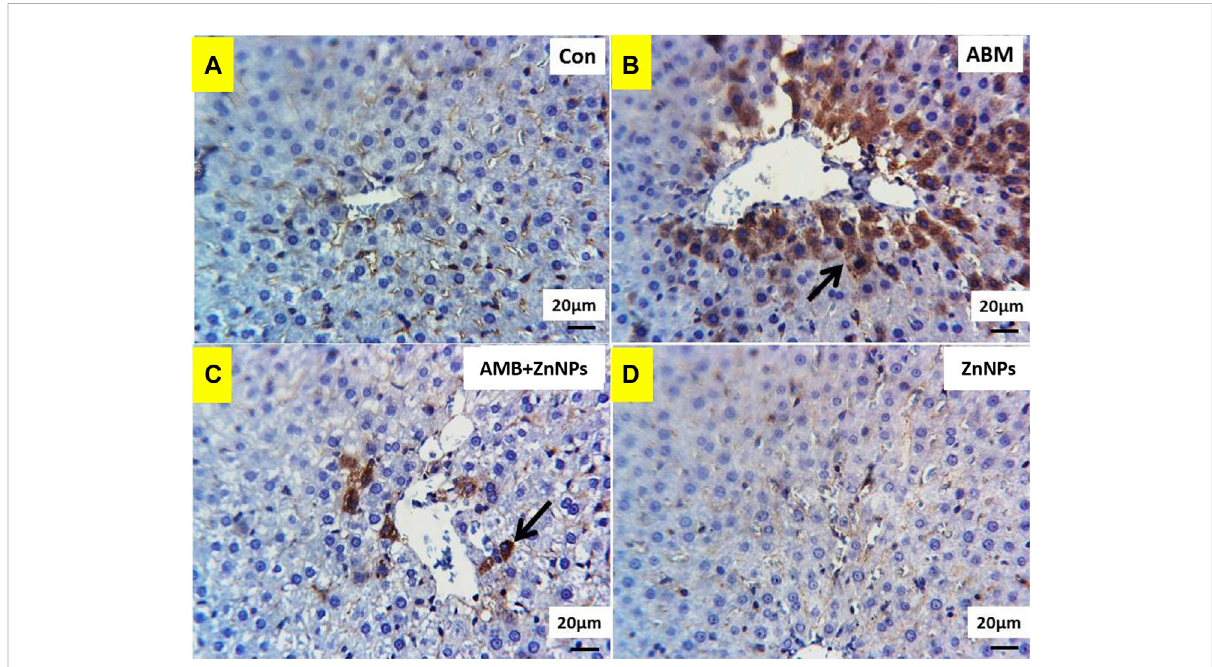
FIGURE 6 PhotomicrographsofCox2immunohistochemistrystaininginhepaticsectionsshowing: (A,D) negativeexpressionsofCox2incontrol(GI)and ZnNPs (G IV), respectively. (B) Massive immunoexpression of Cox2 (arrow) in abamectin (ABM; G II) treated rats group. (C) Reduced immunostaning of Cox2 (arrow) in ABM + ZnNPs (G III) treated rats group. IHC counterstaining with Mayer ’ s haematoxylin. Scale bar 20 μ